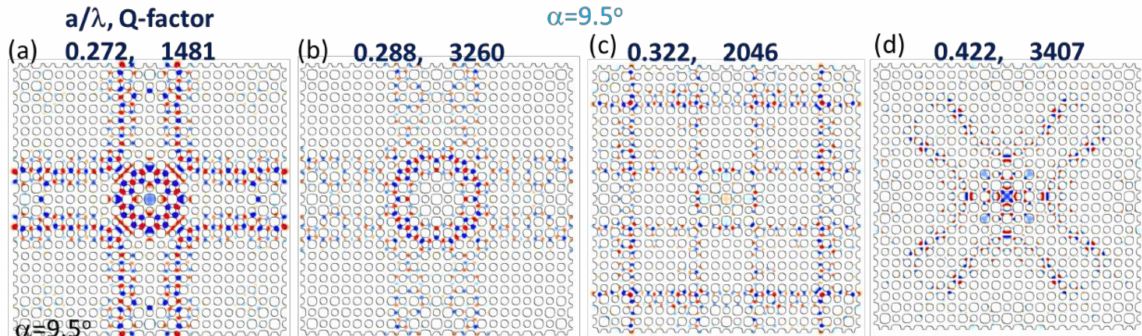
Figure 6. ( a – d ) Simulated electric field intensity for resonance modes in the moir é photonic crystal with a twist angle of 9.5 ◦ obtained at z = 0.34 P z and I th = 26% I max . The frequency a/ λ and Q-factor are labelled in each